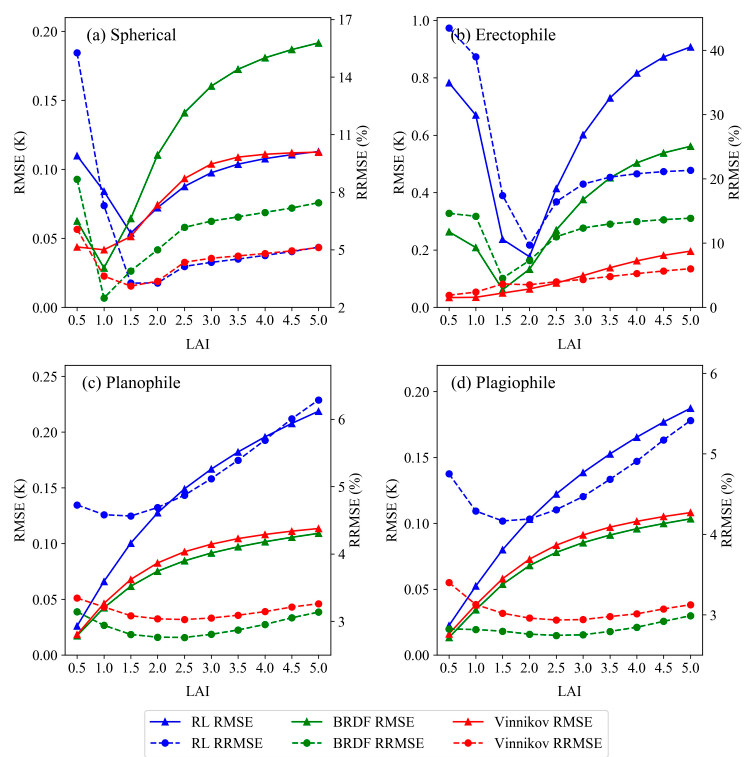
Figure 5. Relative RMSE (RRMSE) of anisotropy fitting error as functions of leaf area index (LAI) using simulations.